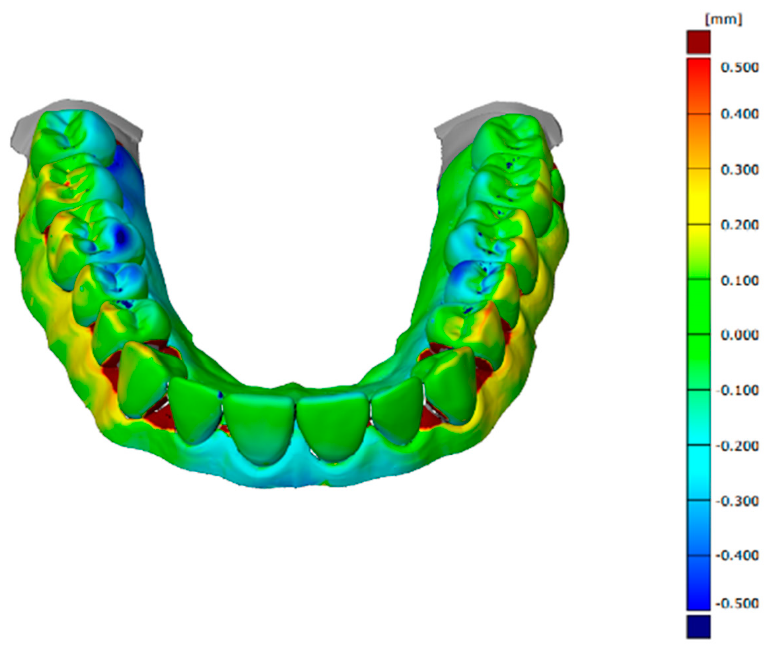
Figure 4. Deviations between the two surfaces when comparing the reference model to the condensation silicone model.